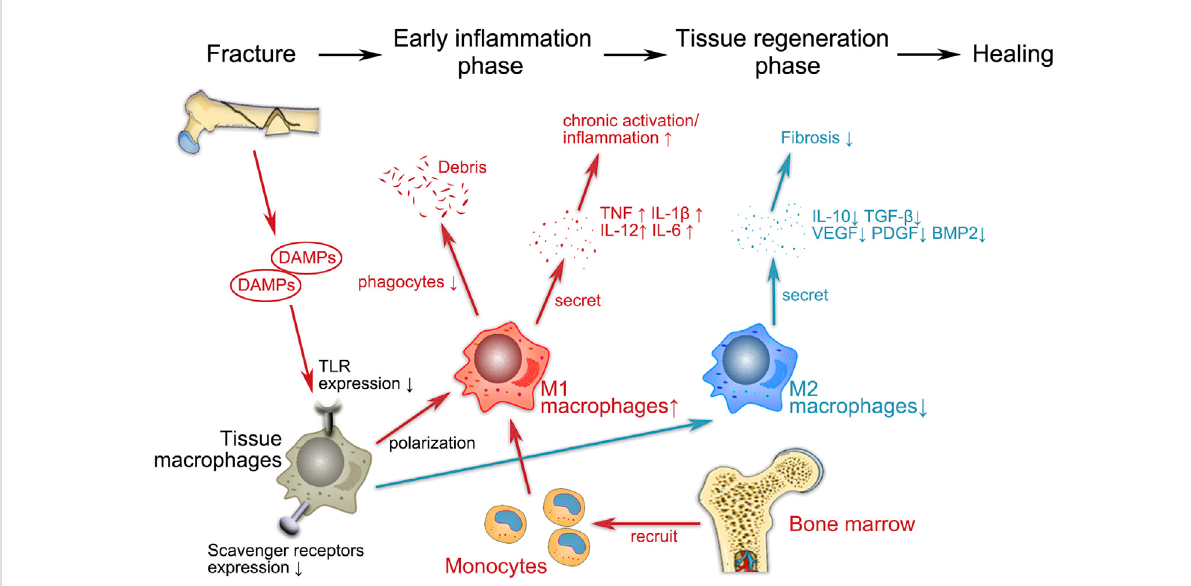
FIGURE 1 Schematic representation of the possible regulatory functions of macrophages in geriatric HF. The entire fracture healing process can be broadly divided into two phases, i.e., the early in fl ammatory phase and the tissue regeneration phase, during which macrophages both play a proin fl ammatory role and regulate subsequent fracture repair. Fractures lead to the release of endogenous cellular DAMPs, which activate macrophagesviaTLR signaling. During thein fl ammatory phase, M1 (proin fl ammatory)macrophagesrecruit monocytes from thebone marrow to the site of injury and participate in the immune response by phagocytosing cellular debris and secreting proin fl ammatory cytokines (e.g., TNF, IL- 1 β , IL-6and IL-12). M1macrophages promoteosteogenesisintheearlyand middle stageswithout enhancingmatrix mineralization. Inthelate repair phase,M2(anti-in fl ammatory)macrophagesreleaseregenerativecytokinessuchasIL-10,TGF- β ,BMP-2andVEGFtoestablishananti-in fl ammatory environment that promotes osteochondral differentiation and angiogenesis. The disruption of the immune system associated with aging inevitably has an impact on various aspects of macrophage activity (e.g., cytokine secretion, polarization, phagocytosis), which indirectly affects the entire process of fracture